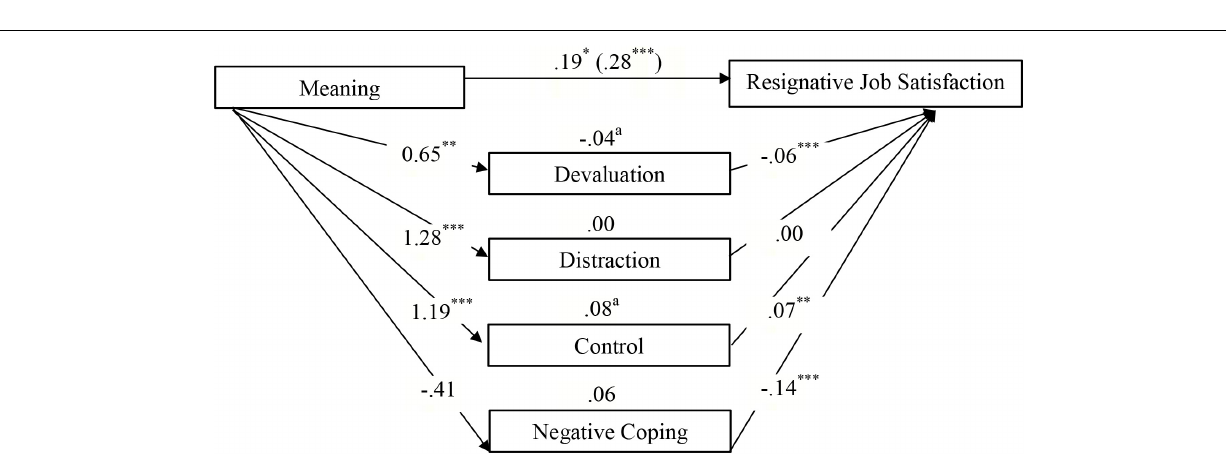
FIGURE 4 | Direct, indirect, and total effects (in brackets) of Meaning on Resignative Job Satisfaction via the mediators Positive (Devaluation, Distraction, Control) and Negative Coping Strategies (Controlled for age and gender). ∗ p < 0.05. ∗∗ p < 0.01. ∗∗∗ p < 0.001. a Significant point estimates ( p < 0.05).